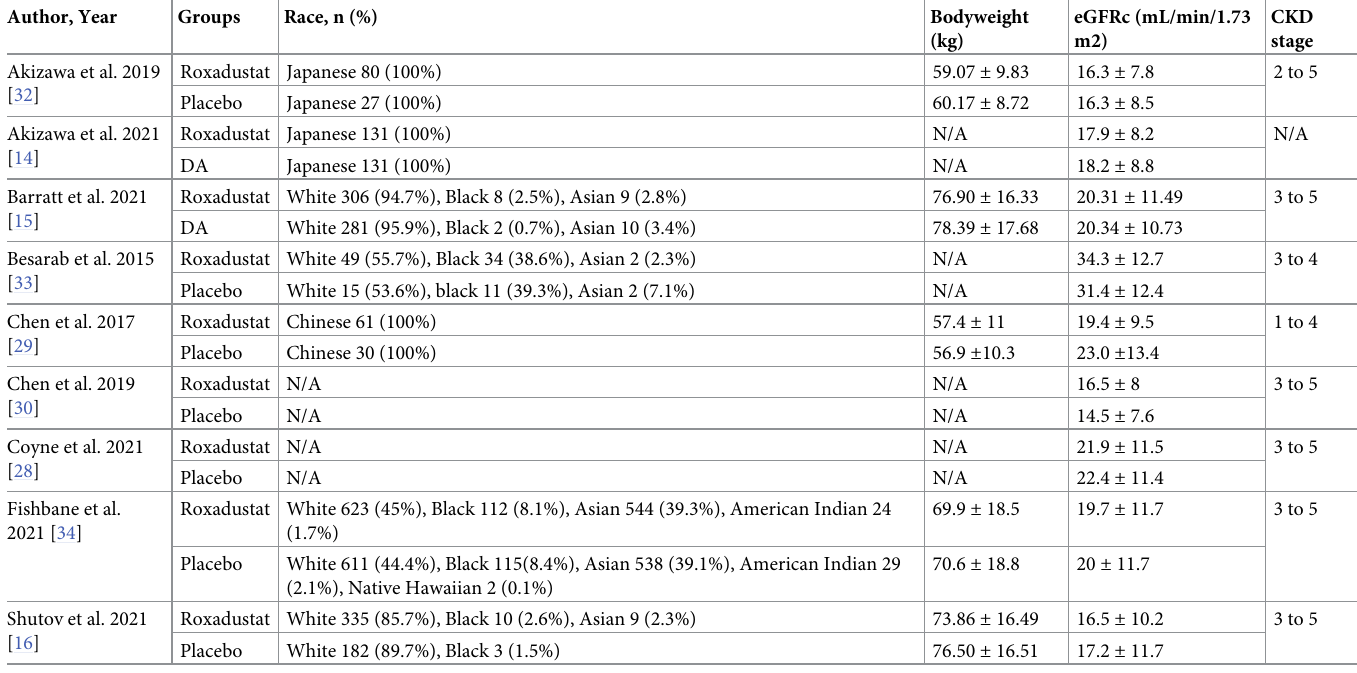
Table 2. The patient demographics and baseline